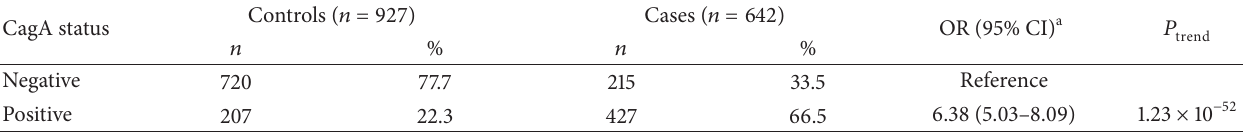
Table 2: CagA status and the risk of